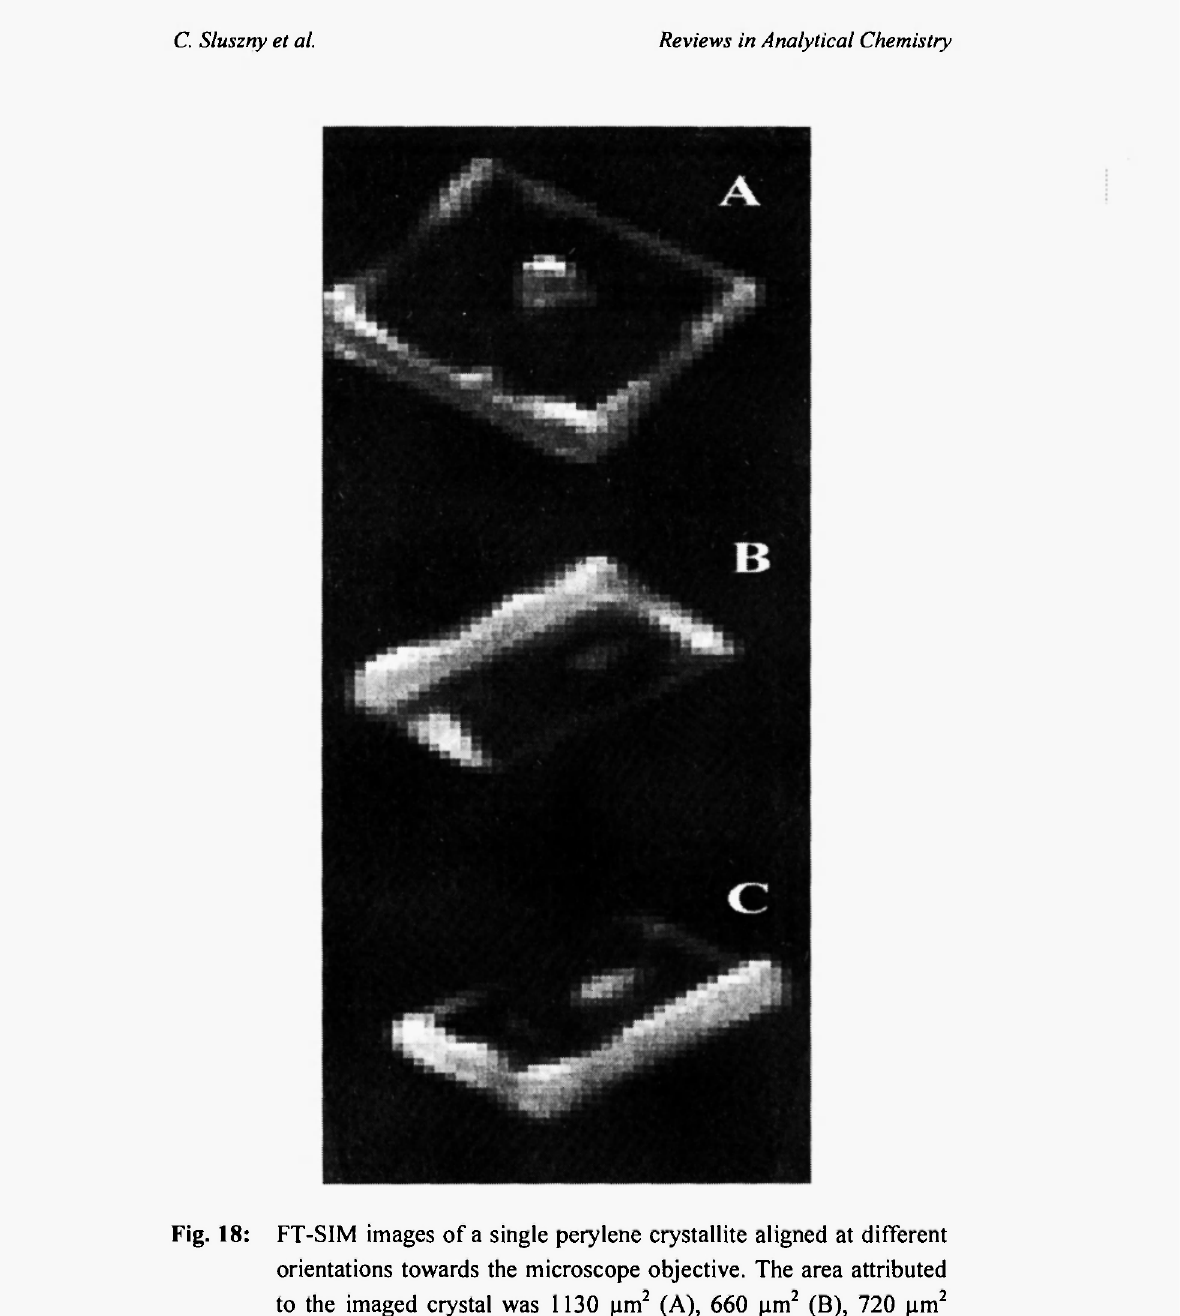
Fig. 18: FT-SIM images of a single perylene crystallite aligned at different orientations towards the microscope objective. The area attributed to the imaged crystal was 1130 μηι 2 (A), 660 μηι 2 (Β), 720 μπι 2 (C).